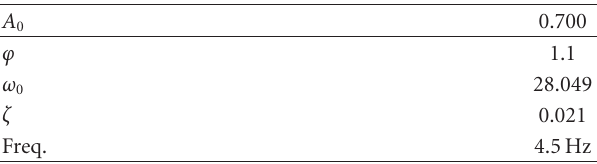
Table 1: Parameters used for calculating the underdamped har- monic oscillator from (5).